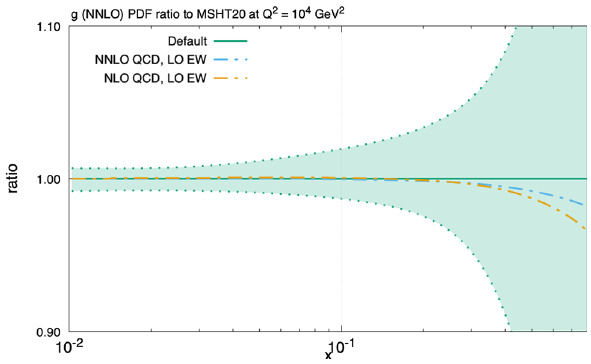
Fig. 14 As in Fig. 13 (left), but for fits with baseline systematic error treatment, but LO EW and NLO QCD + LO EW theory used in